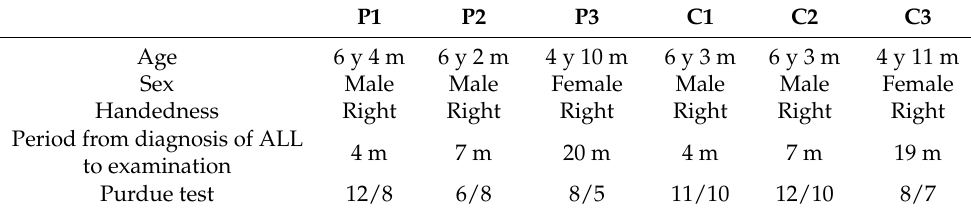
Table 1. Demographic and functional data of patients and control subjects.